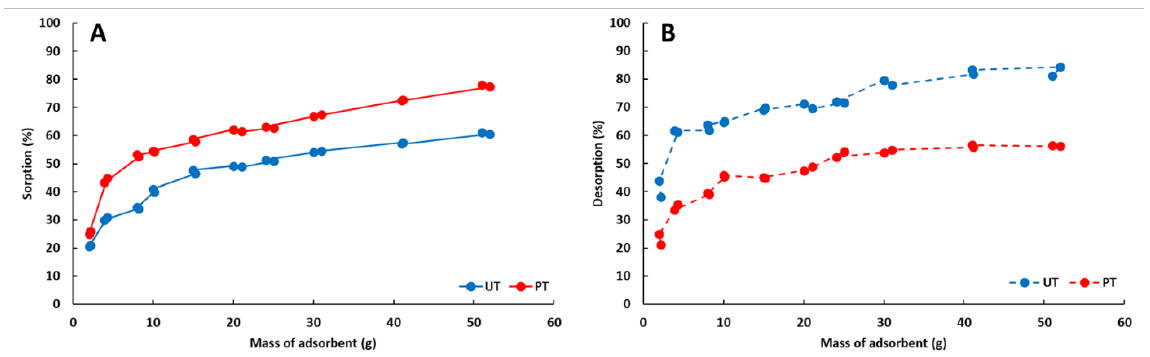
Figure 8. ( A ) Sorption and ( B ) desorption percentage for untreated and polymer treated